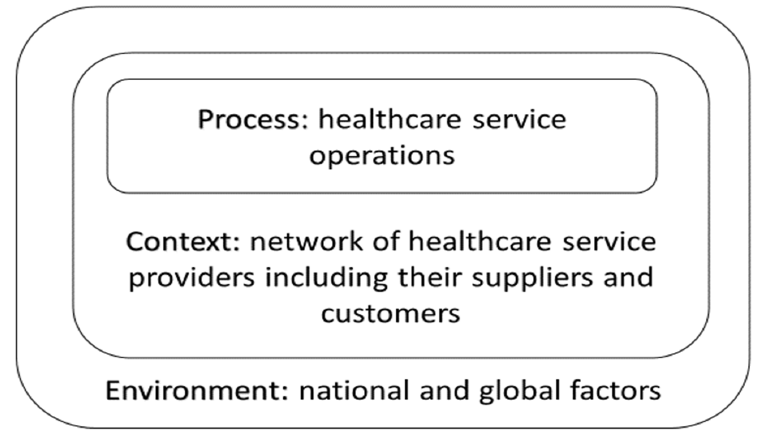
Figure 1. The healthcare service process as embedded unit of analysis [2].